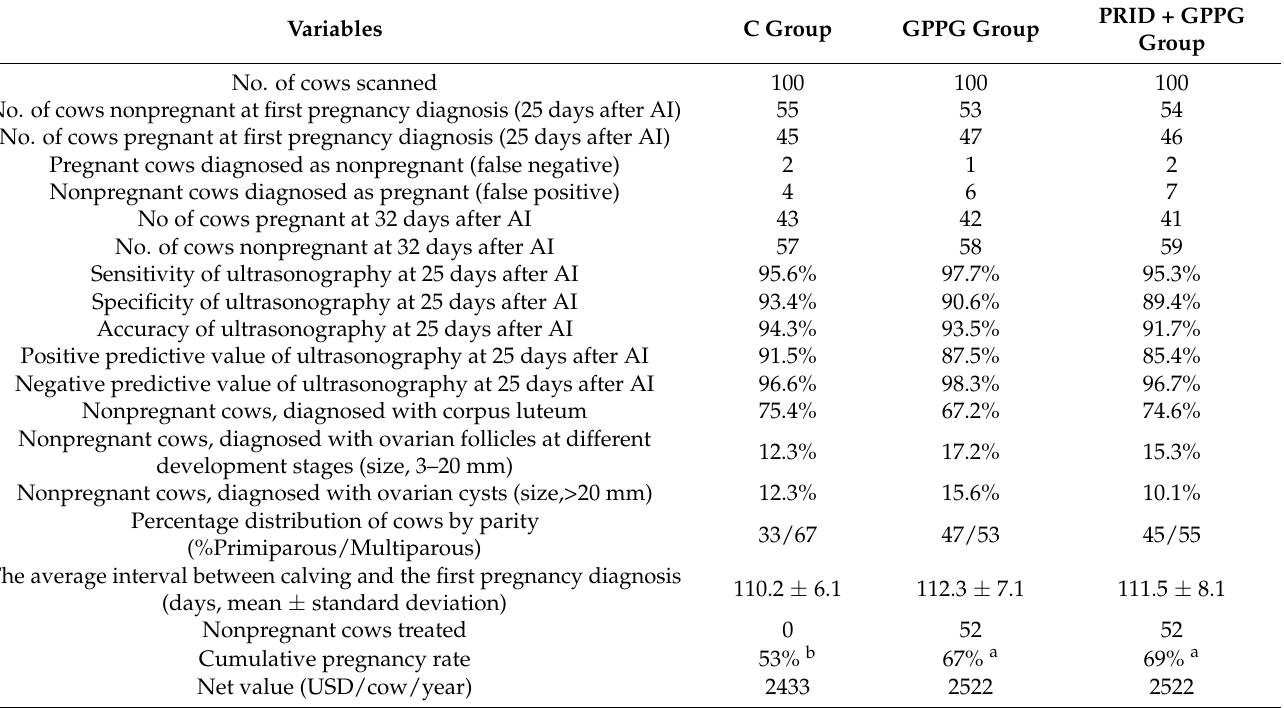
Table 1. Results of the early pregnancy diagnosis, cumulative pregnancy rates, and net present value in GPPG and PRID + GPPG groups compared with the C